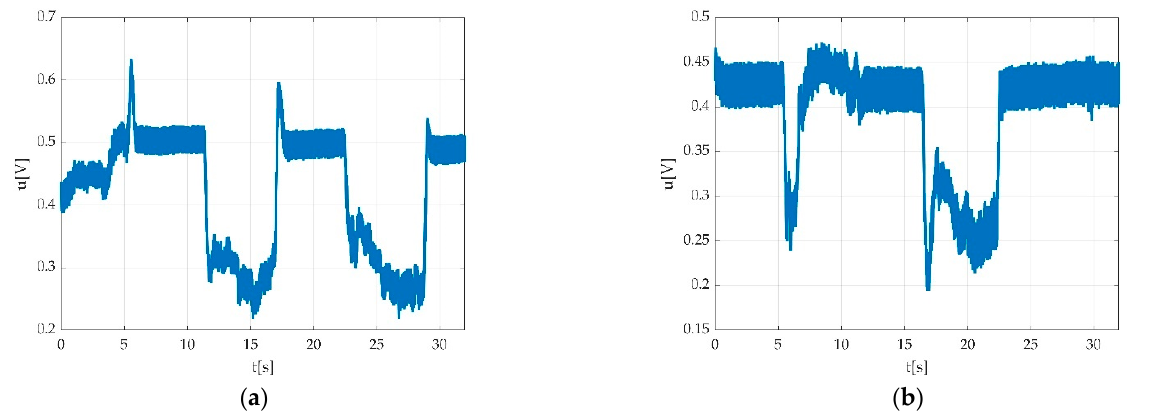
Figure 23. Example of invalid measurement due to: ( a ) participant inability to properly switch from effort to relaxation period during dorsiflexion; ( b ) participant inability to act according to the test protocol on tester command.